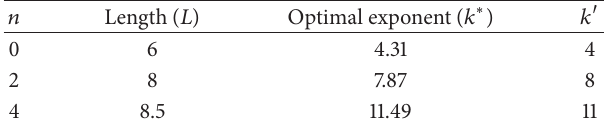
Table 1: Values of 𝑛 , 𝐿 , and 𝑘 ∗ obtained by (S 1 )–(S 3 ).